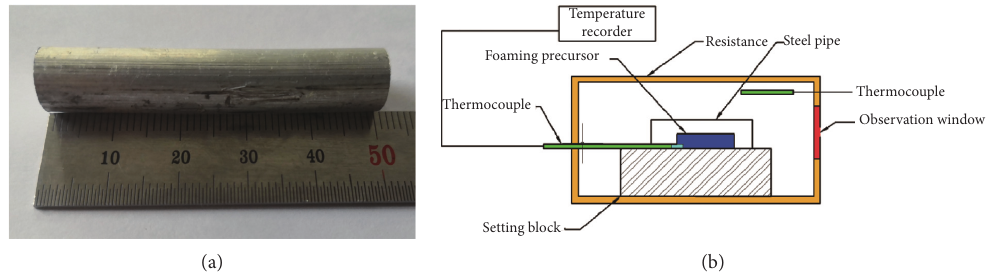
Figure 1: (a) Rod-like precursor prepared by extrusion and (b) schematic of heating the precursor under the in-pipe Table 1: Schematic of the foaming process of a single precursor pipe.